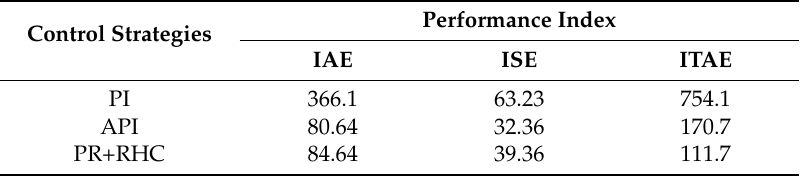
Figure 11. Comparison of PI and Proposed API and PR+RHC controller responses under Single-phase fault, considering: ( a ) Dc-link voltage V dc , ( b ), Stator voltage V s , ( c – e ) Active component of current I d , ( f ) Rotor current I r , ( g ) Reactive component I q , ( h ) Grid current I g , ( i ) Stator active power P s , ( j ) Rotor active power P r , ( k ) Electromagnetic torque T em , ( l ) Stator reactive power Ps react , ( m ) Rotor voltage V r , ( n ) PR+RHC controller THD, ( o ) PI controller THD, ( p ) API controller. Table 11. Performance evaluation of the designed control strategies for V dc . Control Strategies